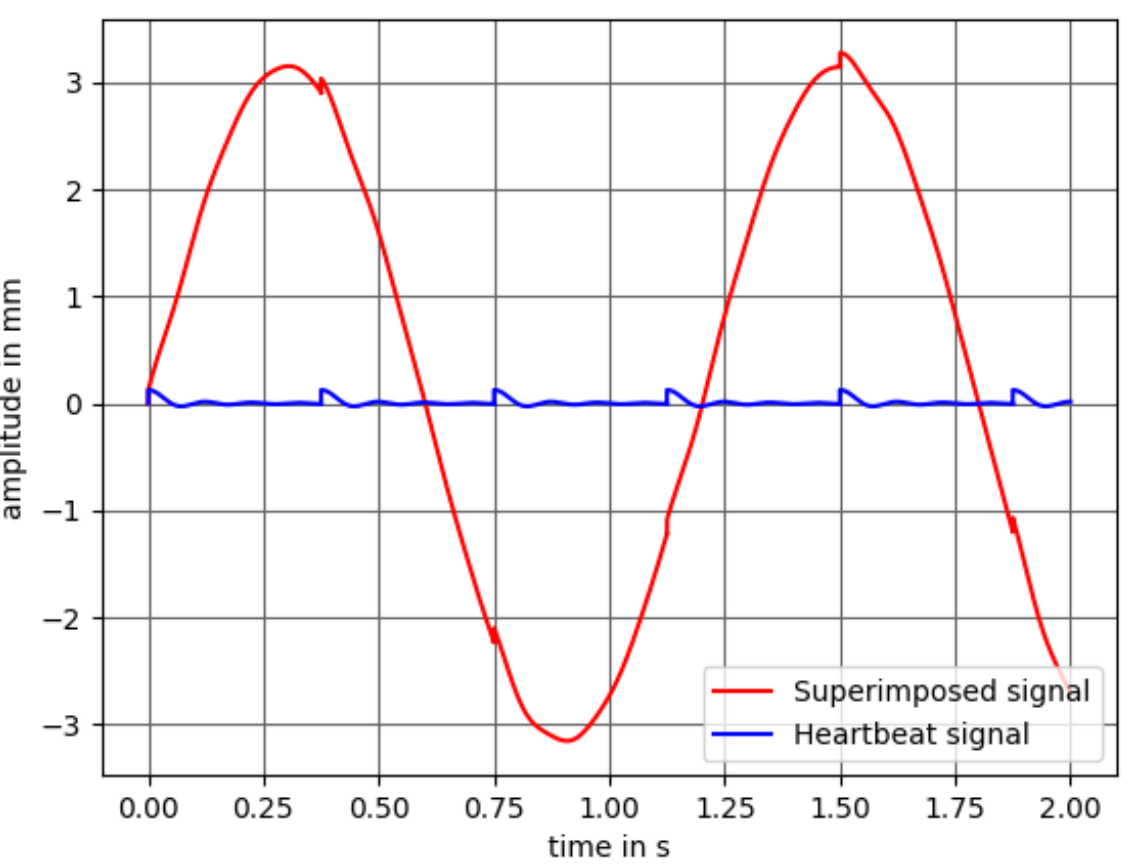
Figure 2. Heartbeat signal ( blue ) with a heart rate of 160beats per minute and respiratory signal of 50breaths per minute superimposed by the heartbeat signal ( red